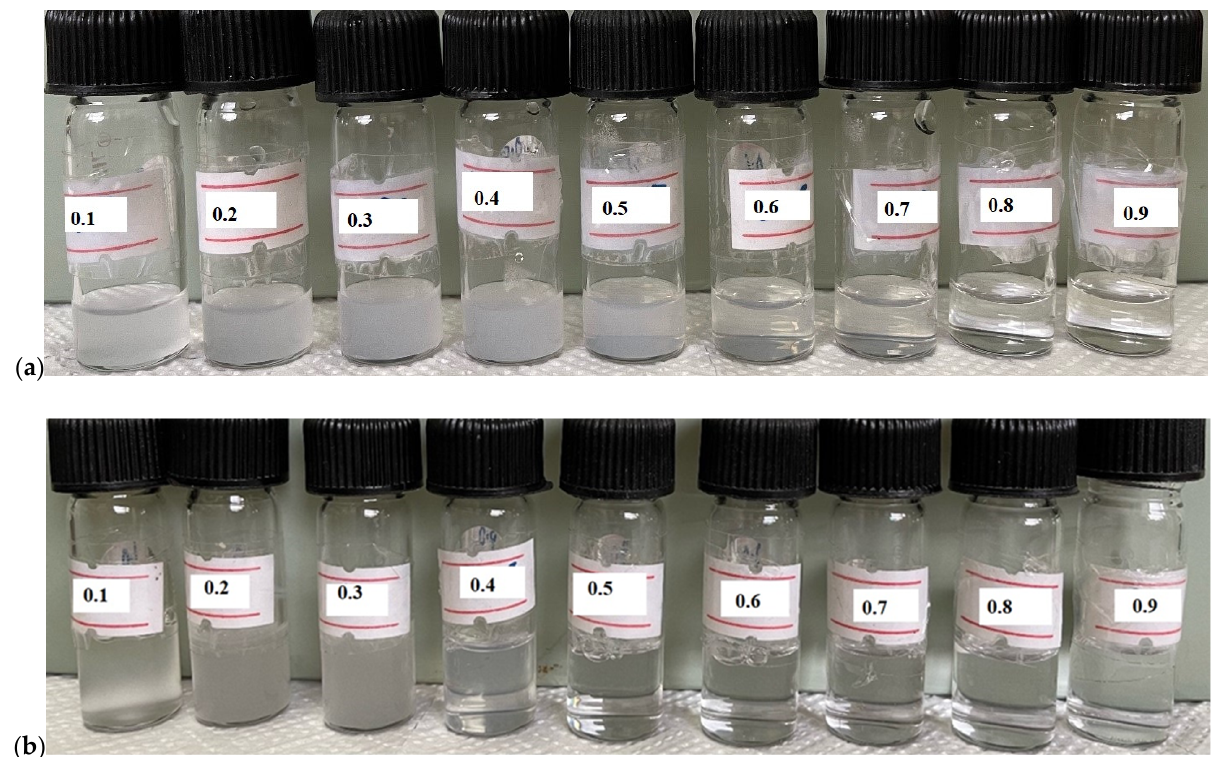
Figure 2. The physical appearance of TCH + SDS/SLS mixtures at different compositions: